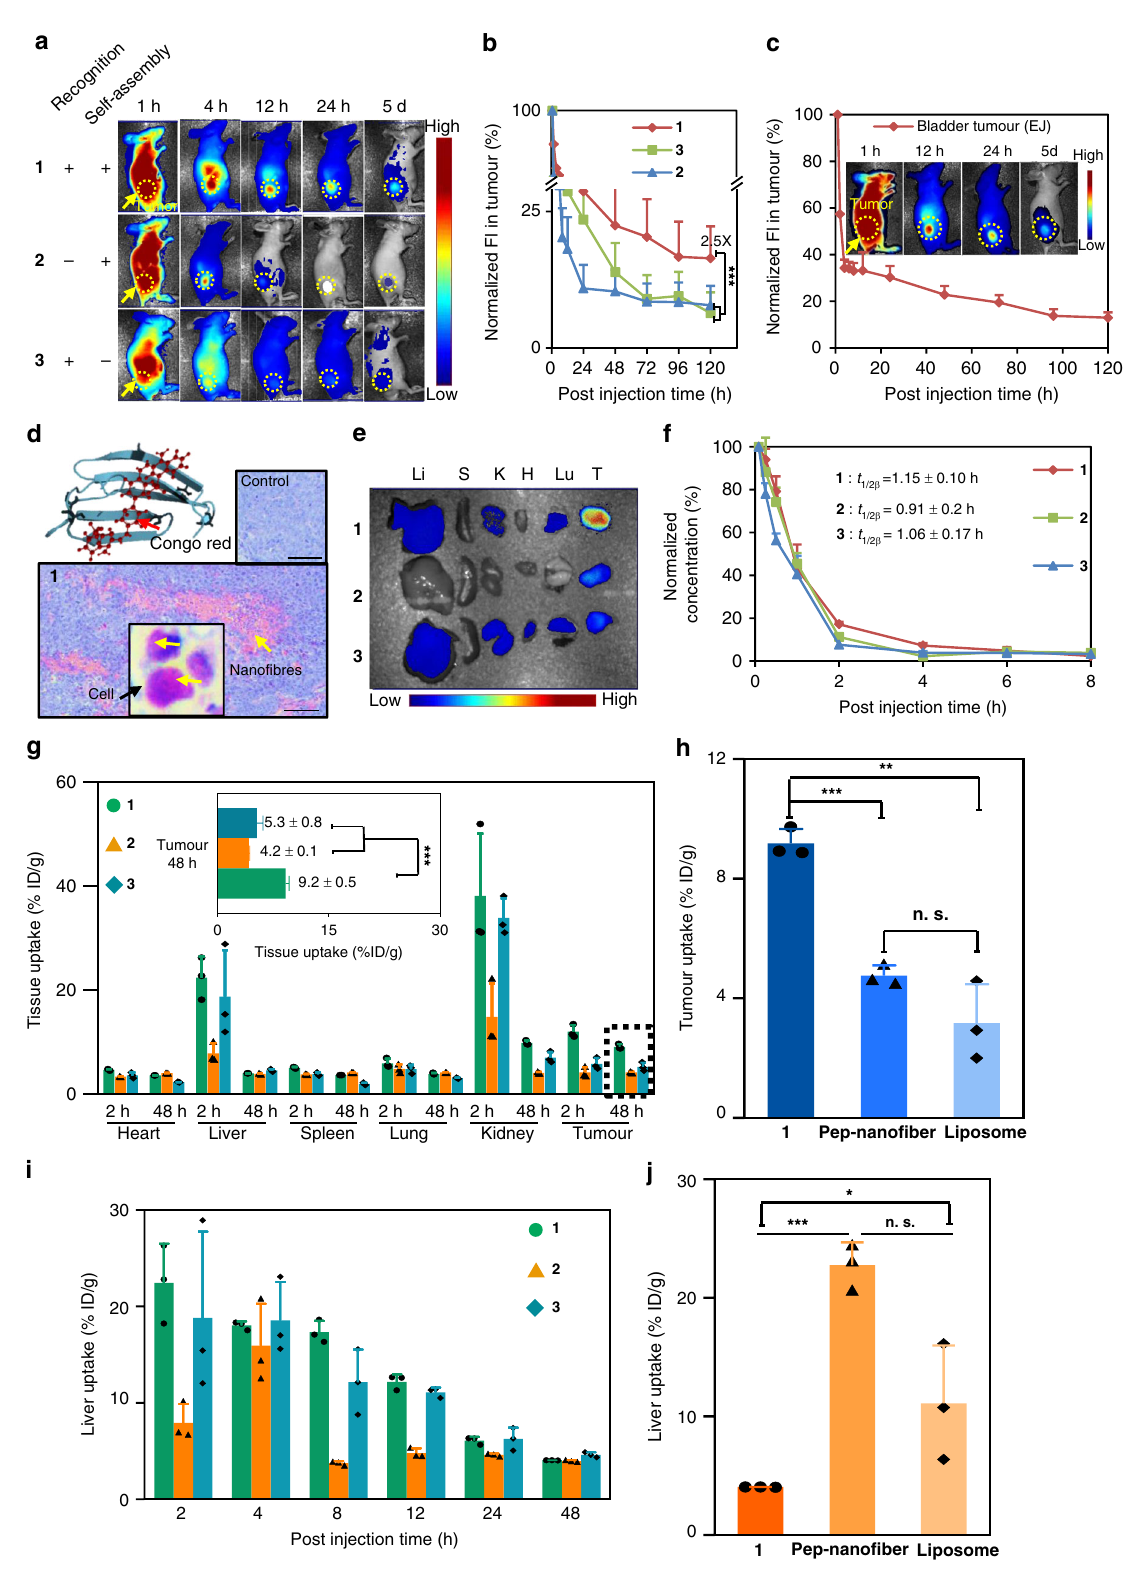
the control groups of mice treated with molecules 2 and 3, a major portion of these molecules were quickly excreted within 4 h (Fig. 4a). To obtain quantitative data on the molecules retention in the tumour sites, we evaluated the integrated fl uorescence intensity in the region of tumour site shown in Fig. 4a and